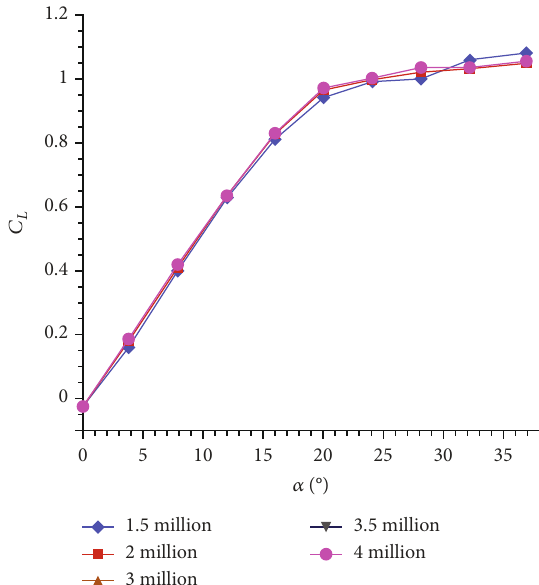
Figure 13: Lifts of di ff erent mesh quantities.